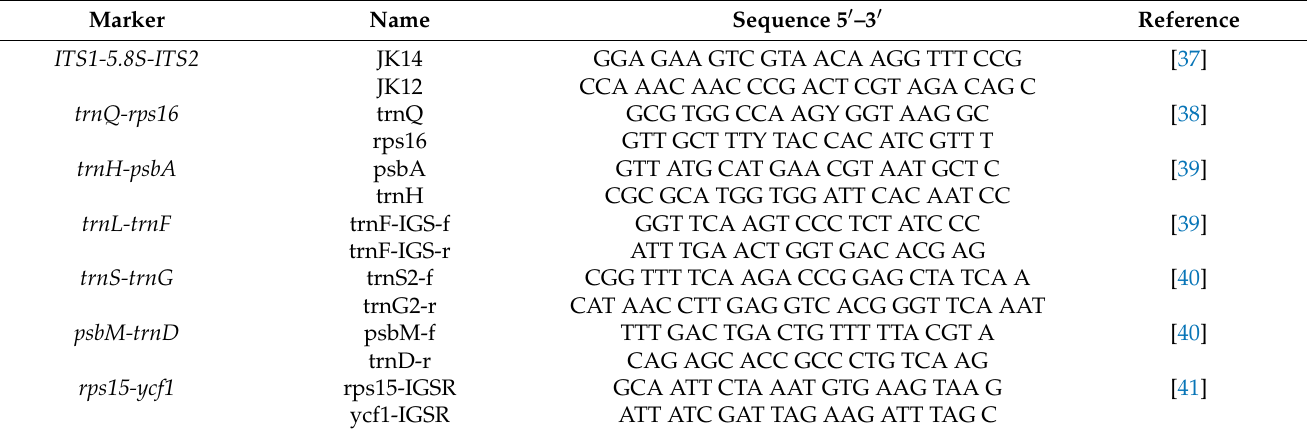
Table 2. Primers used for each molecular marker. The first row of each locus is the forward , while the second row is the reverse .